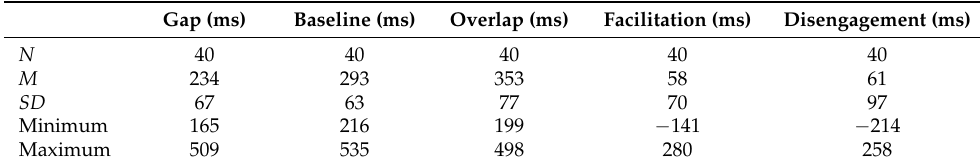
Table 2. Descriptive statistics (untransformed RT) from the Gap-overlap task.